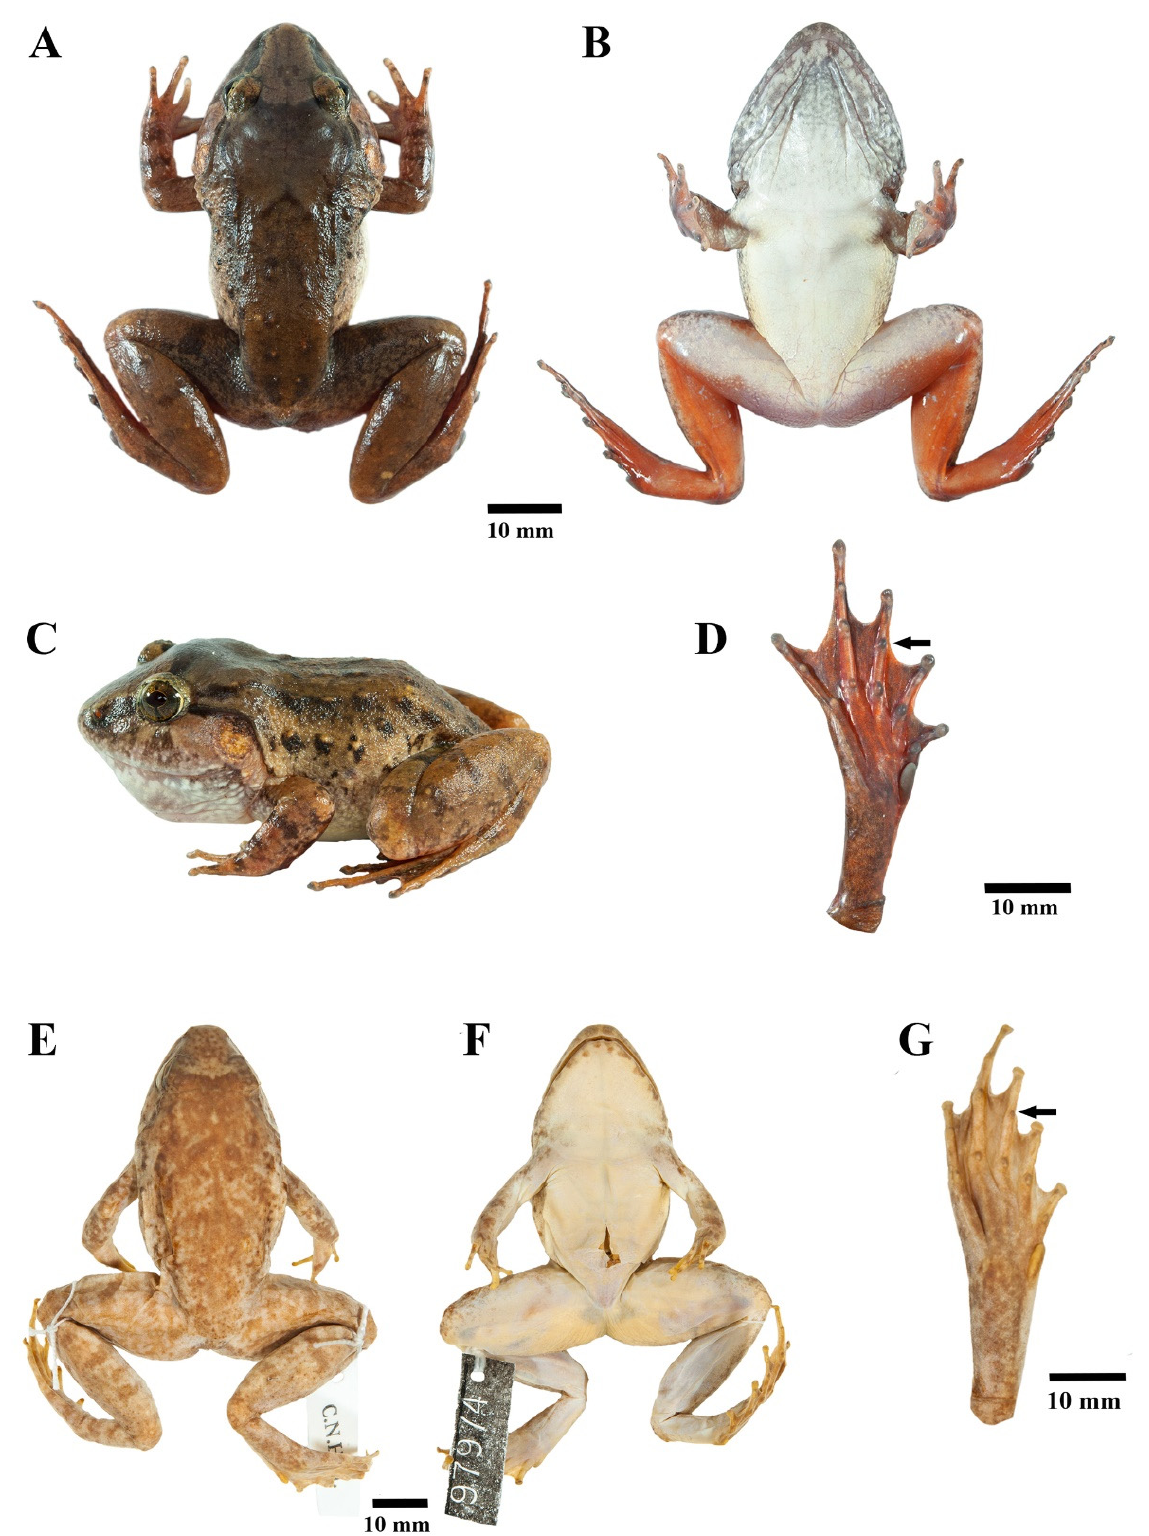
Figure 12. Adult male of Limnonectes doriae in life at Mok Champae Sub-district, Mueang Mae Hong Son District, Mae Hong Son Province, Thailand (ZMKU AM 01546) in ( A ) dorsal view, ( B ) ventral view, ( C ) lateral view, and ( D ) plantar view of the right foot. Paratype female (FMNH 97974) of L. doriae in preservative in ( E ) dorsal view, ( F ) ventral view, and ( G ) plantar view of the right foot. Arrows refer to diagnostic characters in toe webbing.